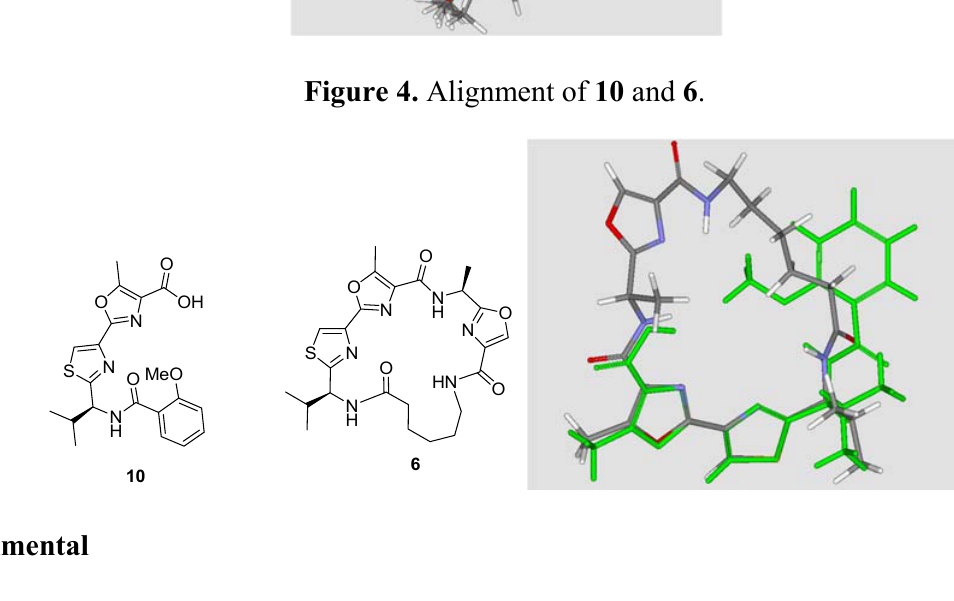
Figure 4. Alignment of 10 and 6